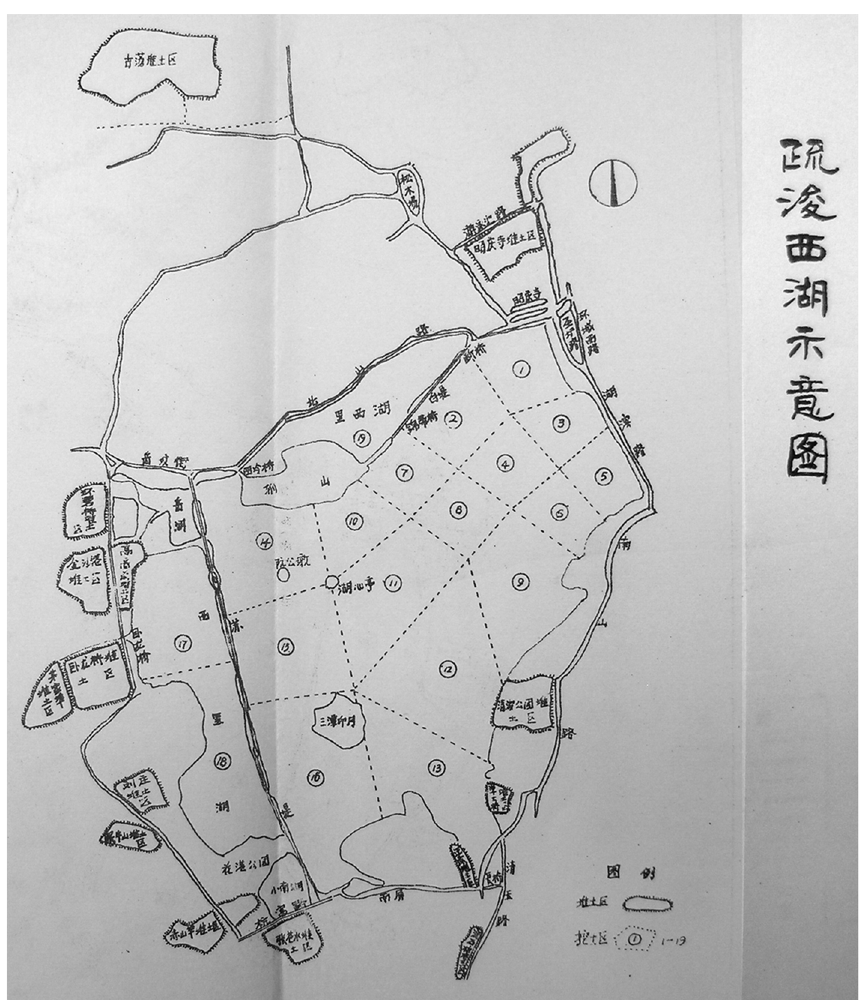
Fig. 4 Draft of West Lake Dredging Project, 1952 (Source: Archives of the Hangzhou Municipal Bureau of Gardening and Cultural